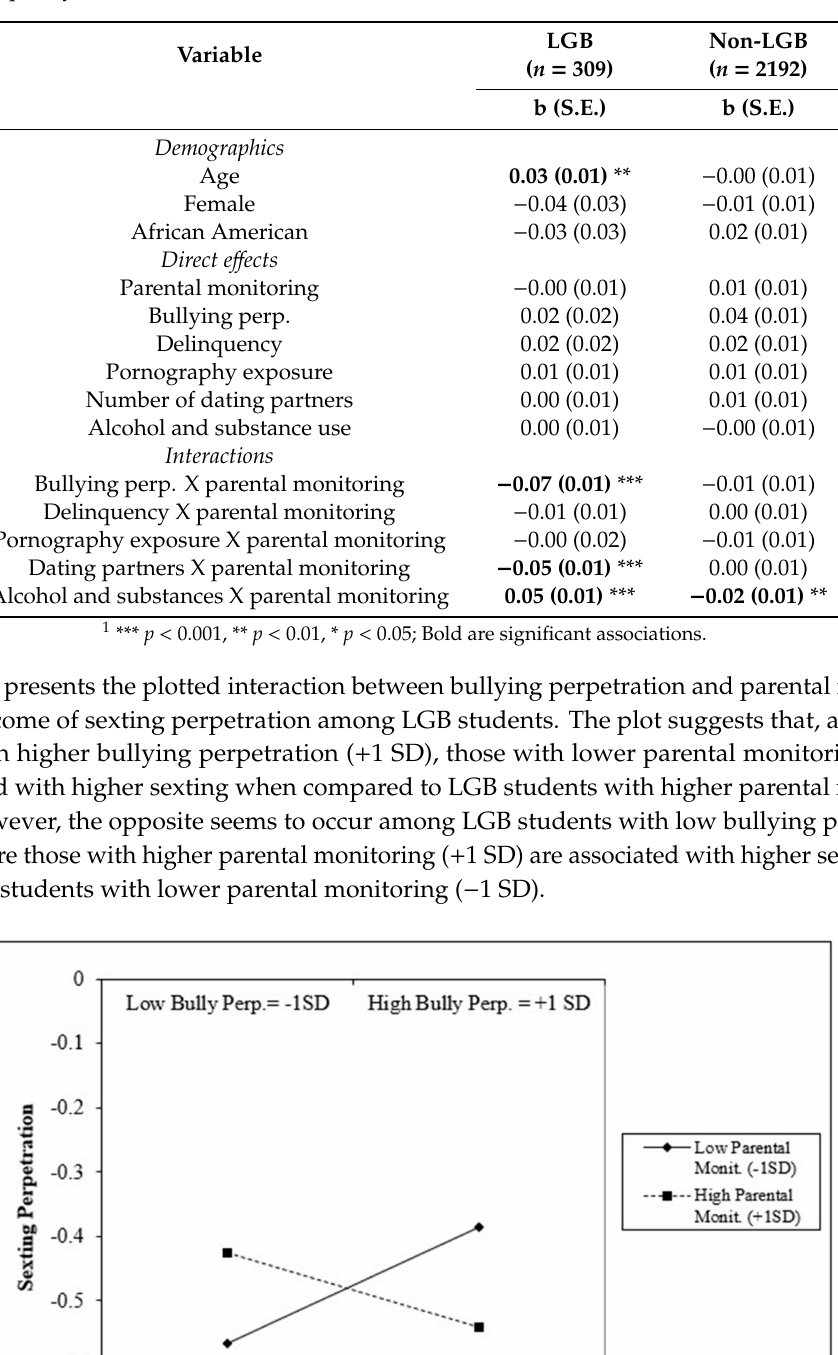
Table 3. Moderation analysis between parental monitoring and bullying and parental monitoring and delinquency. 1